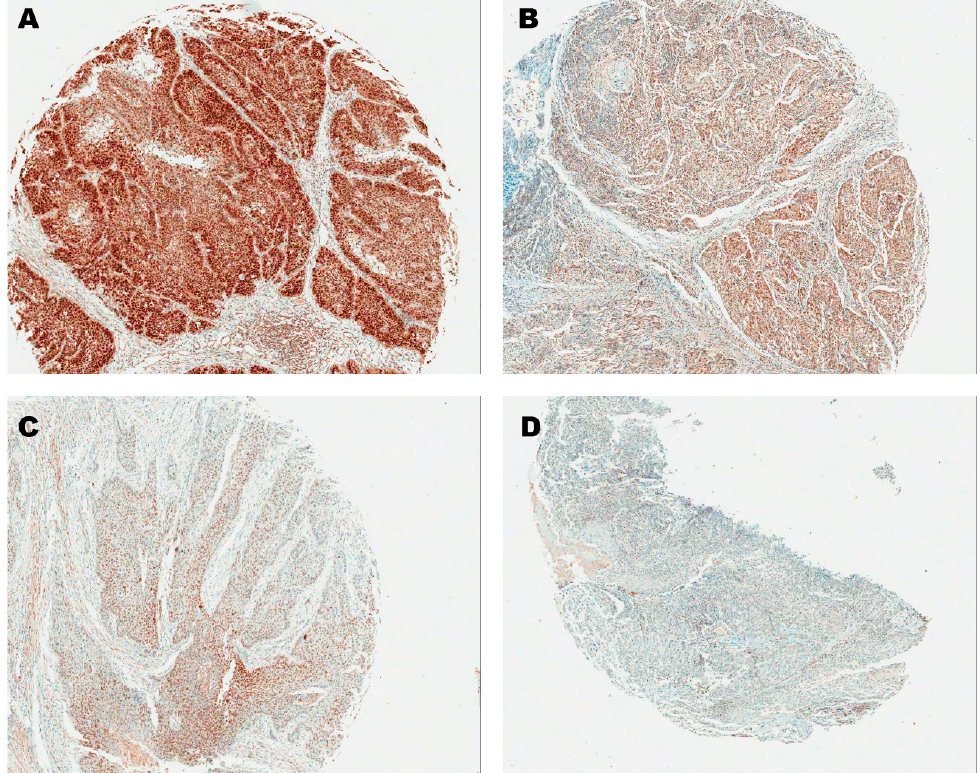
Figure 2. Exemplary images of SOX2 immunohistochemistry staining in tonsil tissue and their corresponding scores (( A ): 30, ( B ): 20, ( C ): 10 and ( D ): 0).